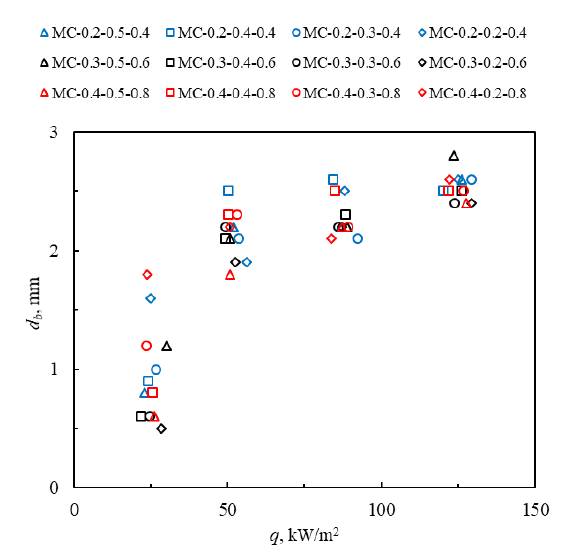
Fig. 4. Averaged departing bubble diameters for ethanol.